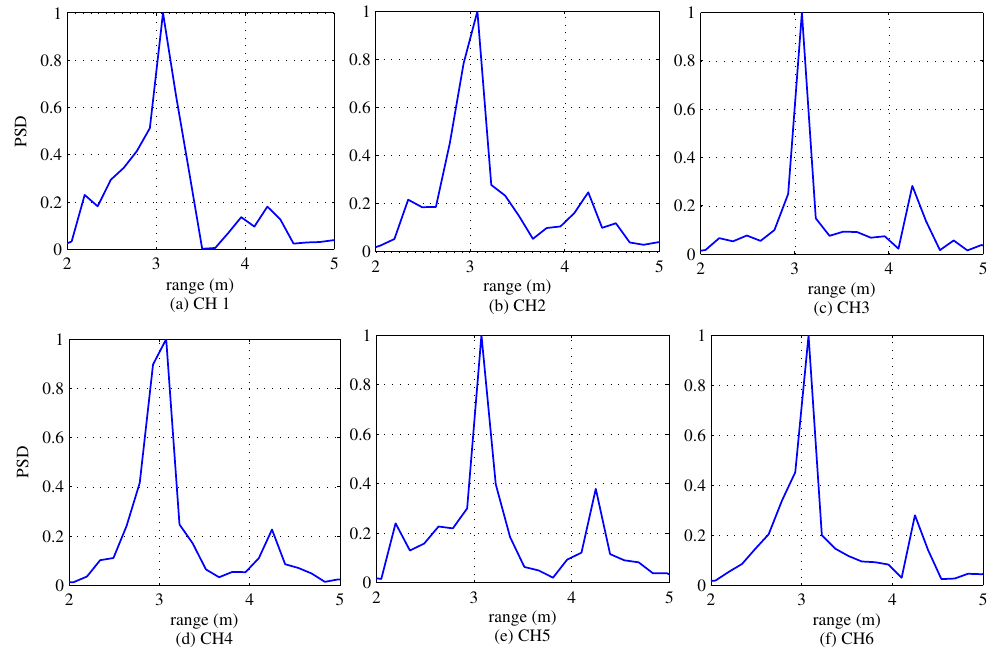
Figure 17. Experiment results of range detection for each